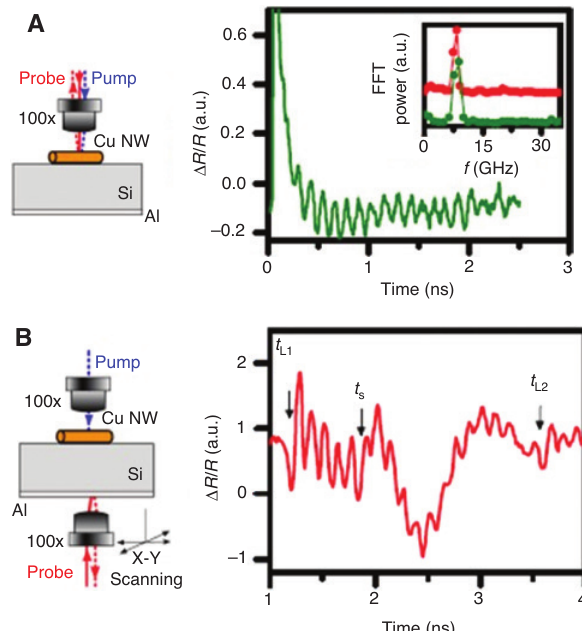
Figure 24: Acoustic field emitted by a single nanowire. (A) Schematic experimental geometry in standard front side experiment. The green curve presents the vibrational response of 400 nm copper nanowire diameter. The FFT insert curve gives an eigenmode at around 8 GHz, exactly superimposed on the FFT response measured at the opposite surface. (B) Schematic experimental geometry in back side experiment. The red curve presents the vibrational response emitted by the nanowire emerging = 1.2 ns at the second free surface [116]. Reproduced with after t l1 permission [116]. Copyright (2016) American Chemical